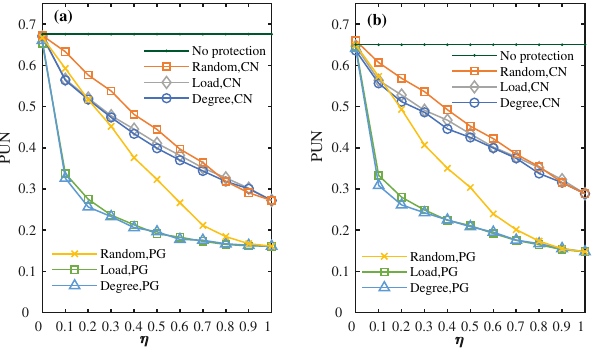
Figure 5. Robustness of CPS changes as a function of proportion of protected nodes η when P = 0.5. ( a ) Node–Link, RC; ( b ) Node–Node, RC.